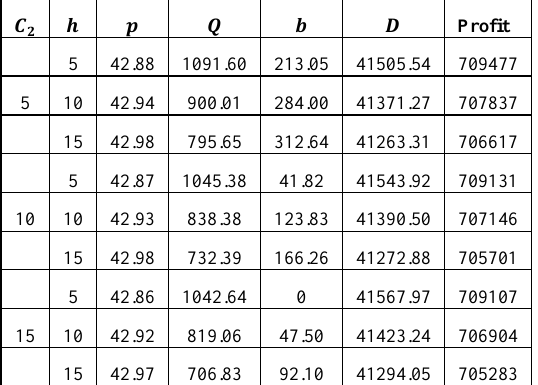
Table 2. Effect of changing the holding cost and shortage cost on the selling price, optimal order level, backorder level, and retailer’s expected profit